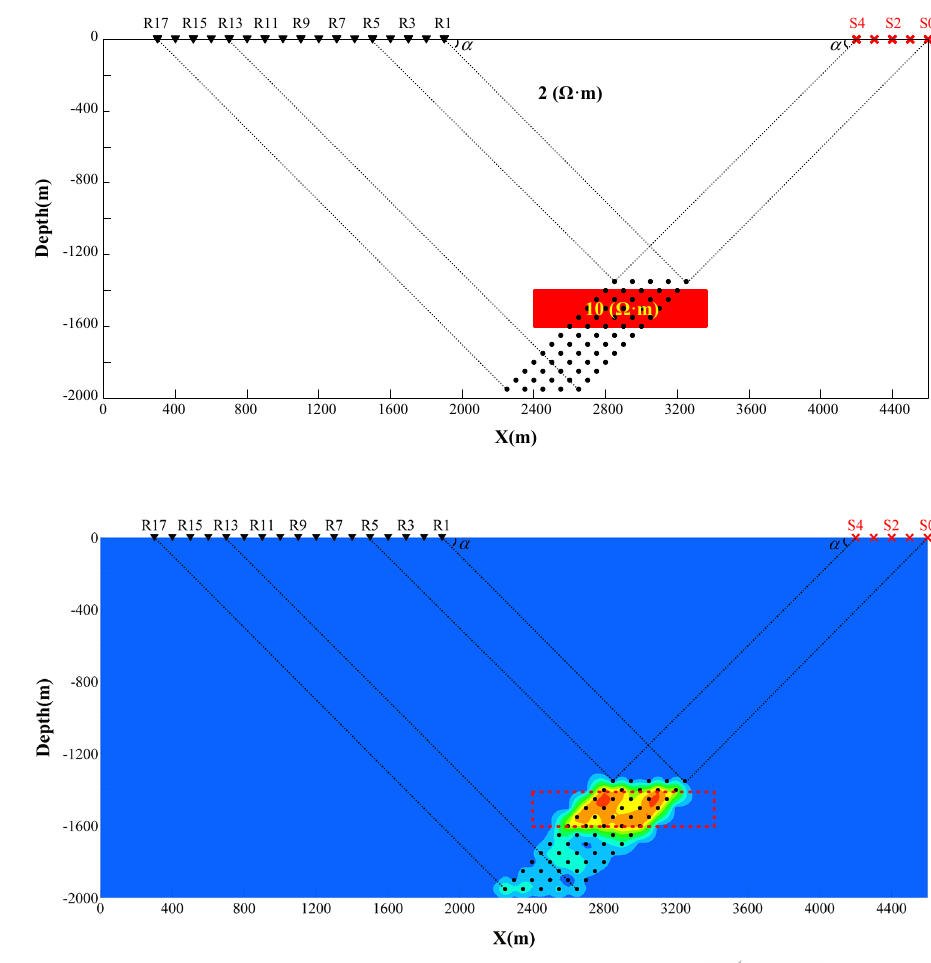
Fig. 5 MCSEM apparent resis- tivity geometry imaging profile